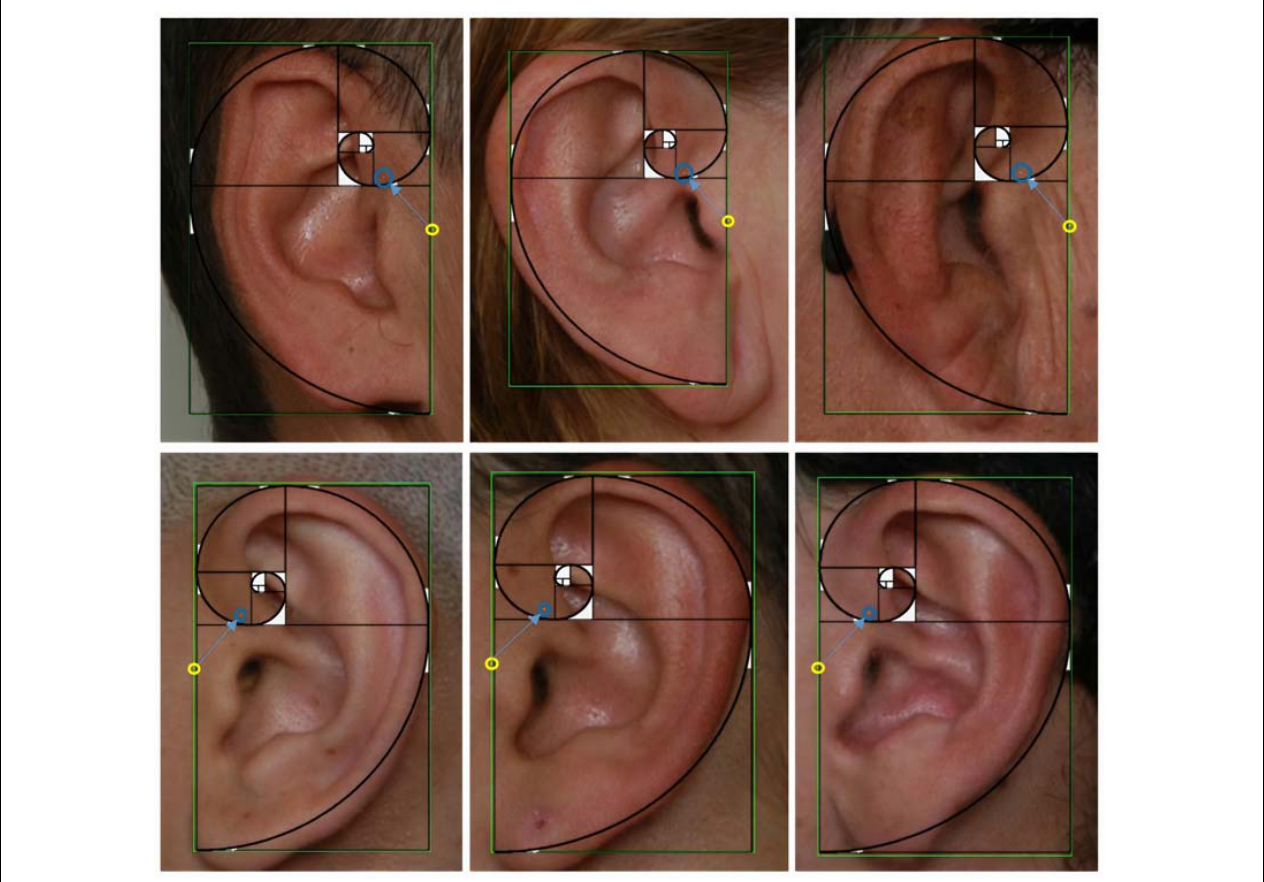
FIGURE 12 | Ear detection results, correction of the closest point toward the preauricular point, and verification of the coordinates with the Fibonacci spiral.